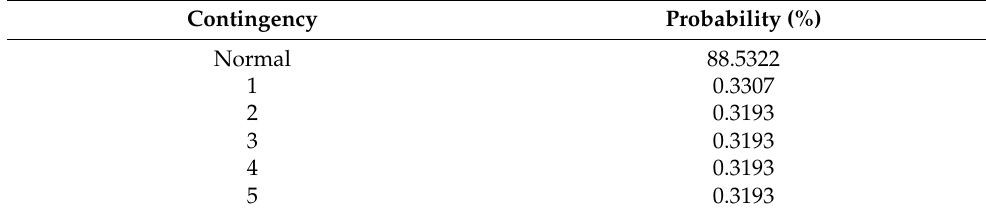
Table 4. Probability of happening for the